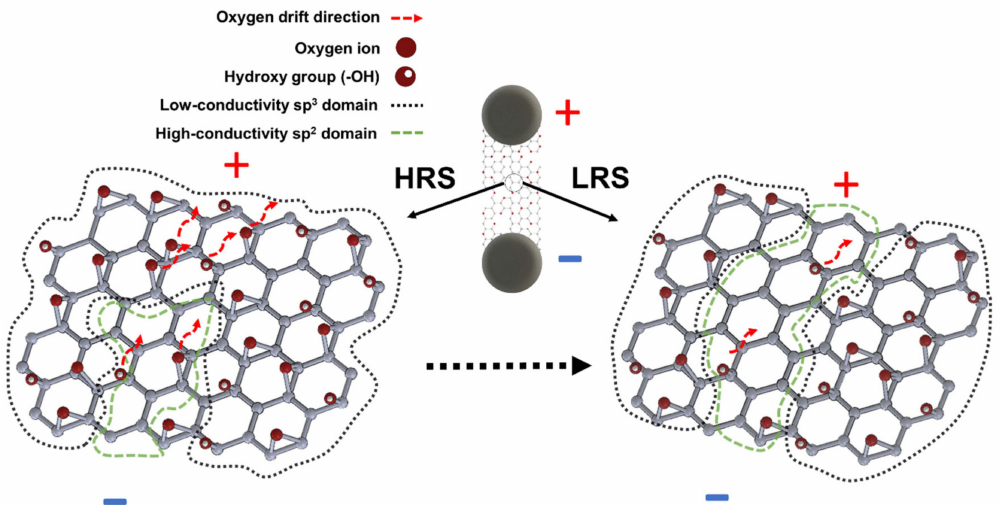
Figure 5. Conceptual model of the origin of the resistive switching of laser-fabricated graphene oxide memristors illustrating the transition from HRS to LRS. Starting from an HRS state, under the action the current flow, the electrostatic potential is mostly applied on the non-conductive sp 3 domains resulting in large local electric fields. The sp 2 based conductive domain (area surrounded by the green dashed line) is extended by the field-assisted migration of oxygen ions, creating a local high conductivity path leading to an LRS